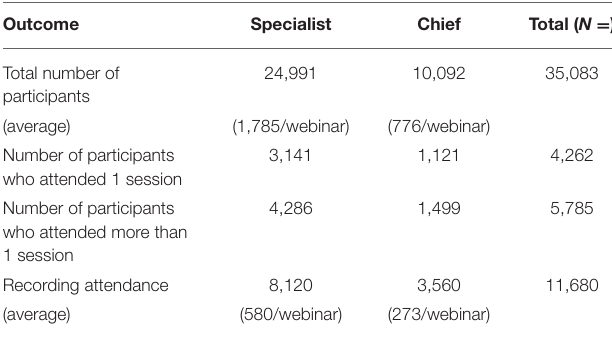
TABLE 2 | Participation data for Specialist and Chief